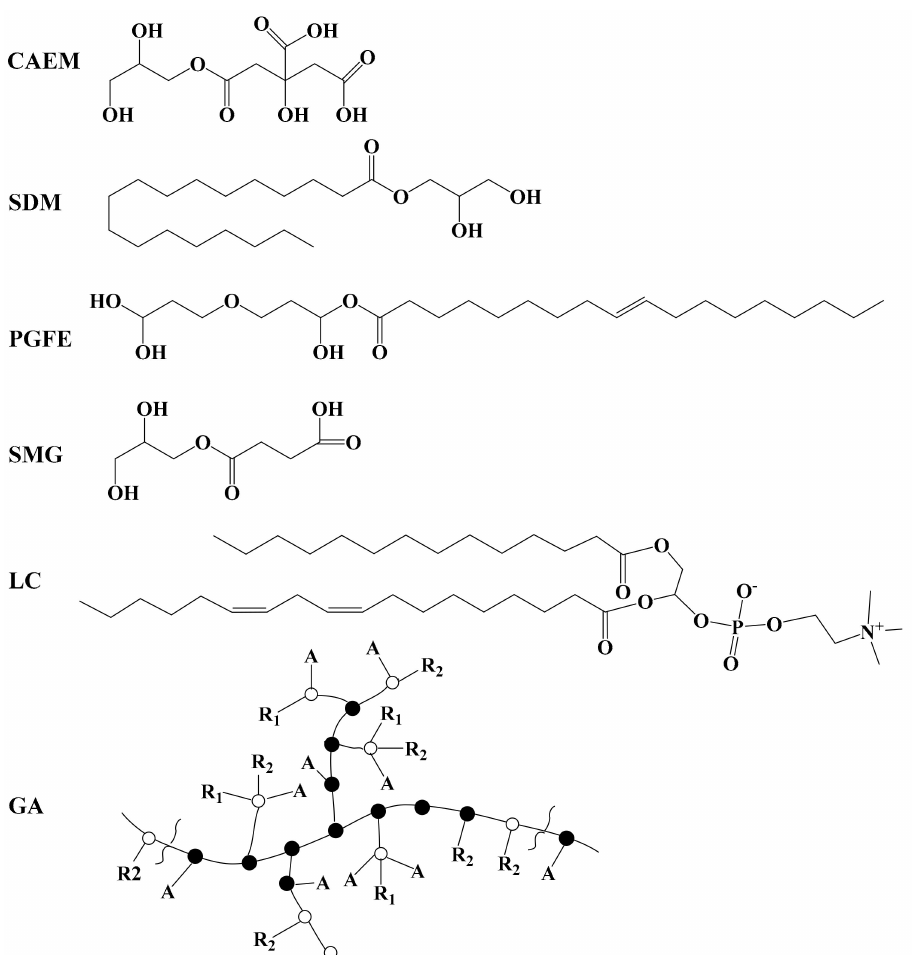
Figure 3. Molecular structures of citric acid ester of monoglyceride (CAEM), saturated distilled monoglyceride (SDM), polyglycerol fatty acid ester (PGFE), succinylated monoglyceride (SMG), lecithin (LC), gum arabic (GA). A = arabinosyl; (cid:8) = 3-linked Gal p (Gal p attached); Glc p attached), or end-group; R 1 > Rha → 4GlcA (Rhaoccasionally absent, or replaced by Me, or by Ara f ); R 2 = Gal → 3 Ara; R 3 = Ara → 3 Ara → 3